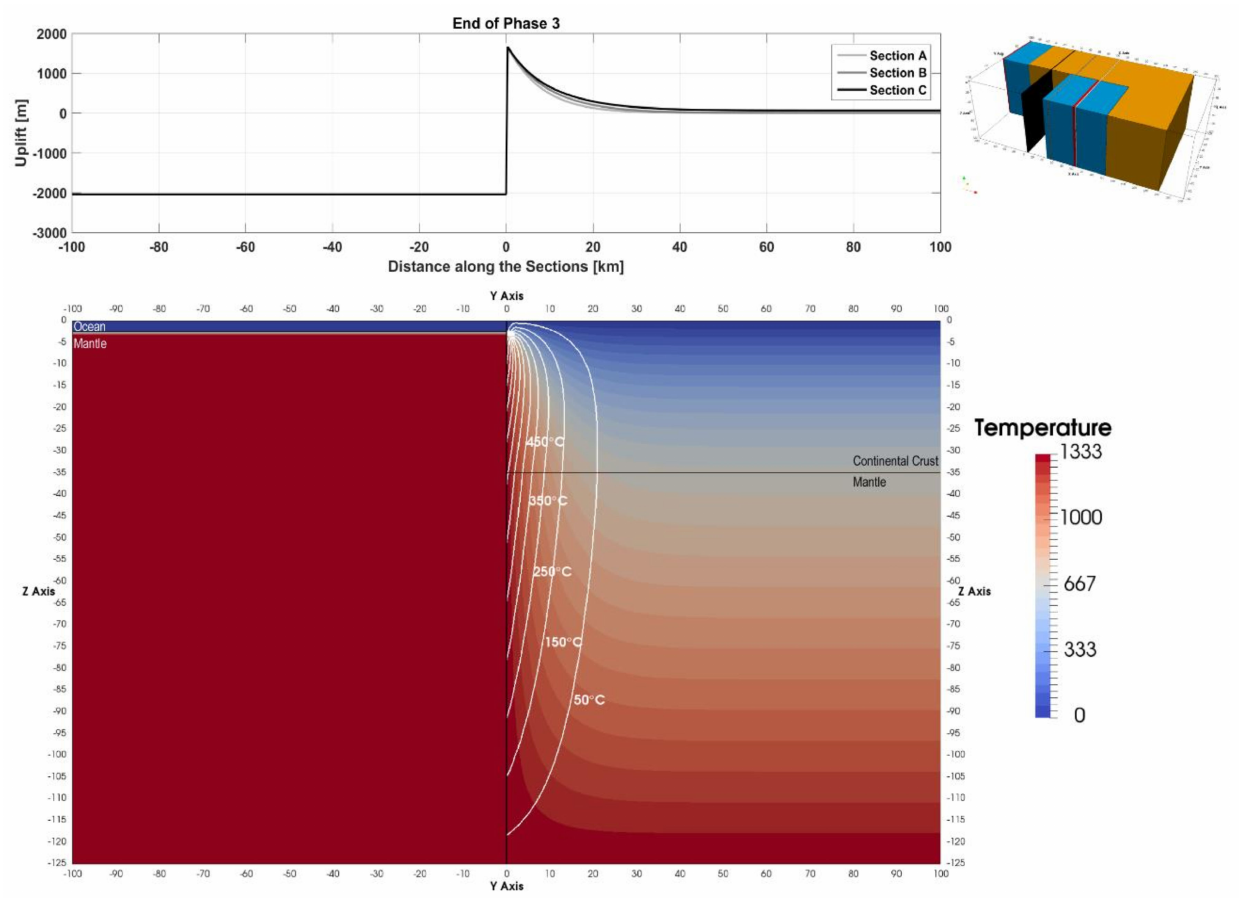
Figure 4. Thermal structure of the continental lithosphere along Section A at the end of Phase 3 (5.5 Myr). The thermal anomaly (white contour) extends 20 km laterally into the continental lithosphere across the transform margin. The vertical central line denotes the transform margin. The lithosphere to the left of the margin is the trailing edge of the 5 km wide ridge crest. The excess temperature contours are restricted to the northern side of the transform margin. The upper left panel shows the corresponding uplift calculated along all the sections at the end of Phase 3. Note that given their different initial positions, the time to reach the end of Phase 3 is different for the three sections. The upper right image shows the model configuration at the end of Phase 3 for Section